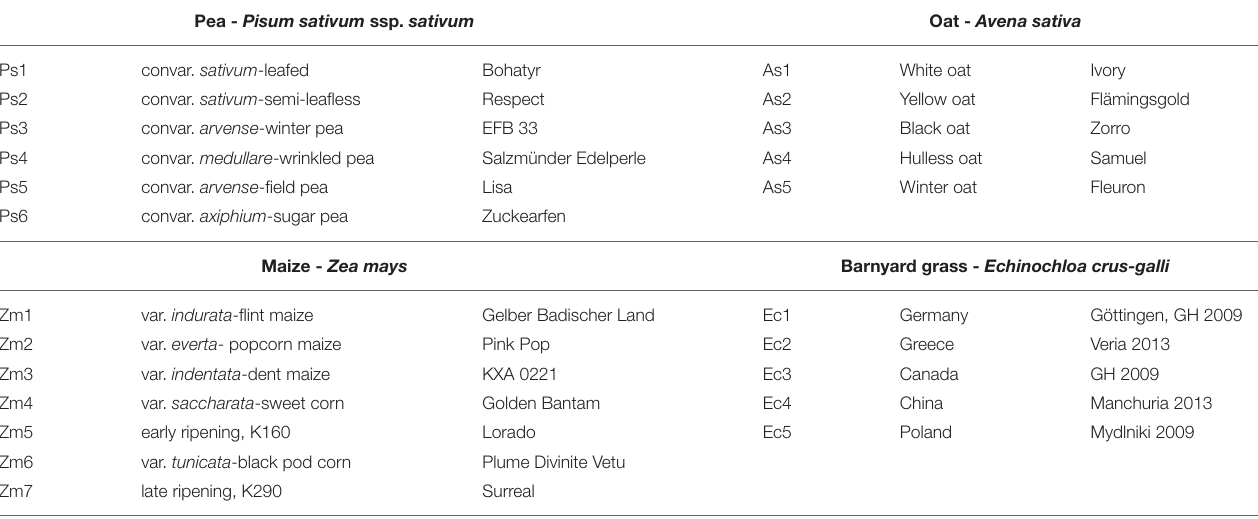
TABLE 1 | Cultivars and proveniences of the different species used for the experiments. Pea - Pisum sativum ssp. sativum